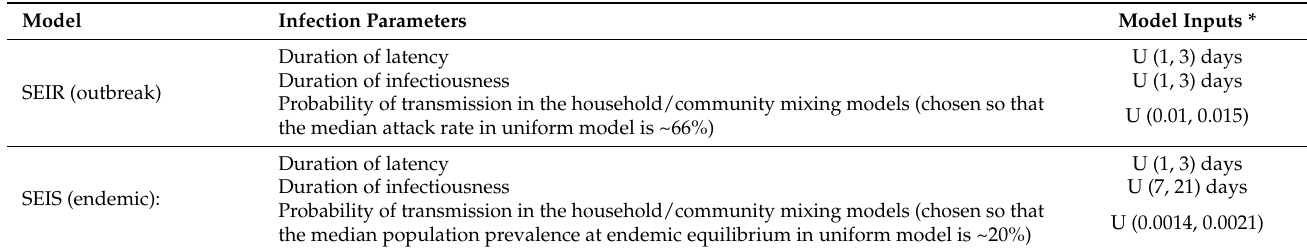
Table A3. Infection parameters for the outbreak and endemic disease models.